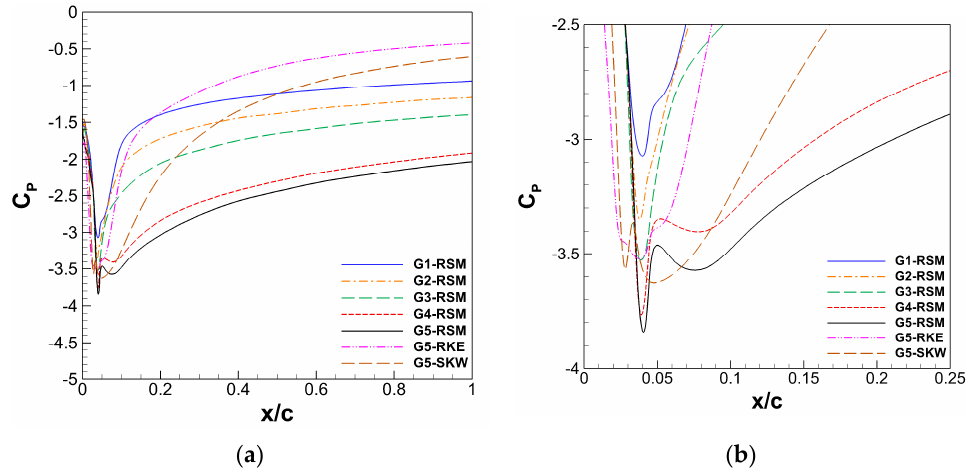
Figure 7. Pressure coefficient profiles along the vortex core: ( a ) global; ( b ) close-up view around the minimum pressure.